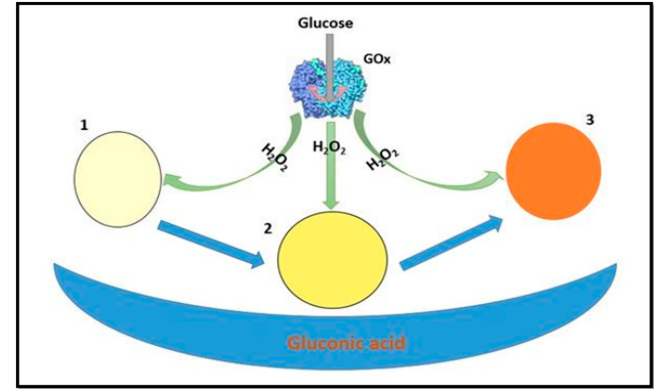
Figure 3. Ceria Paper based, colorimetric glucose sensor, color change of nanoceria-based filter paper from white (1)-yellow (2) to dark orange (3) [70].